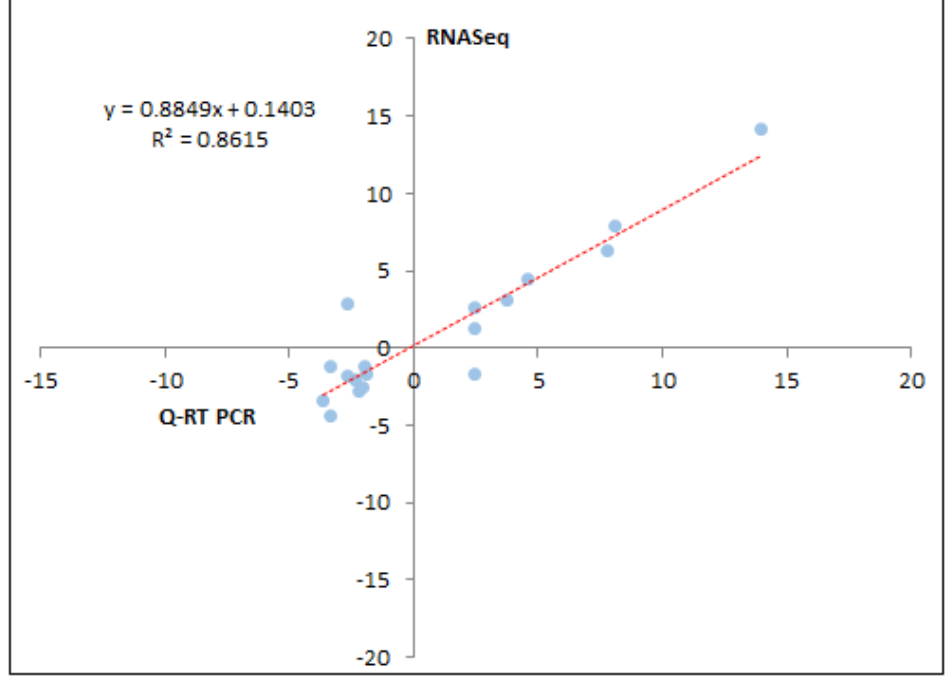
Figure 4. qRT-PCR validation of RNA-Seq results, using the top 10 DEGs from male and female groups Figure 4. qRT ‐ PCR validation of RNA ‐ Seq results, using the top 10 DEGs from male and female respectively. The fold change from q-RT PCR was plotted on the x -axis, and the log 2 fold change from groups respectively. The fold change from q ‐ RT PCR was plotted on the x ‐ axis, and the log 2 fold the RNA-Seq analysis was plotted on the y -axis; and the correlation between the two methods is given change from the RNA ‐ Seq analysis was plotted on the y ‐ axis; and the correlation between the two in the methods is given in the figure.